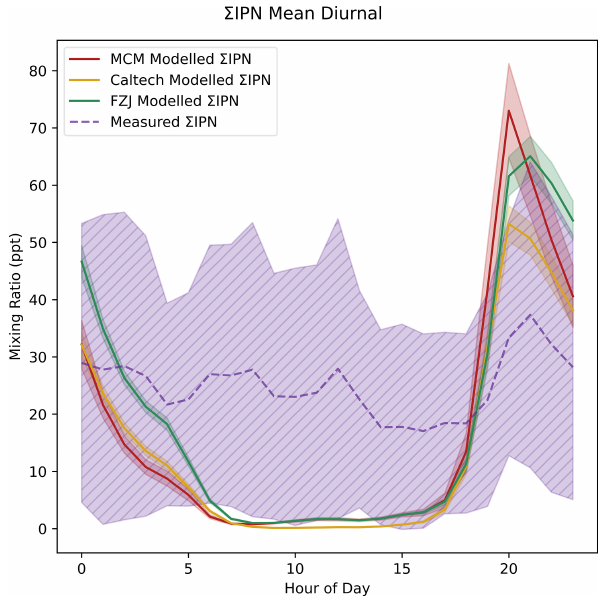
Figure 10. Measured and modelled (cid:54) IPN (a) . Each line shows the mean value for each dataset, with the shaded area indicating 1 stan- dard deviation above and below the